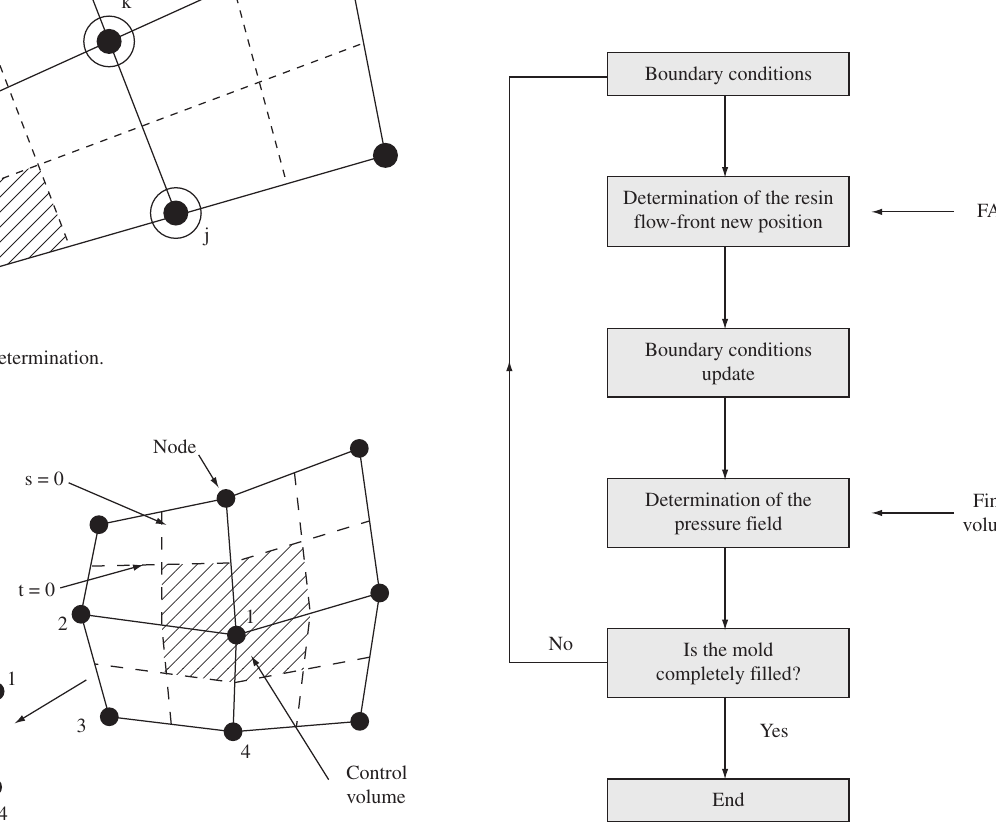
Figure 3. Control volume creation. Figure 4. Algorithm used in the